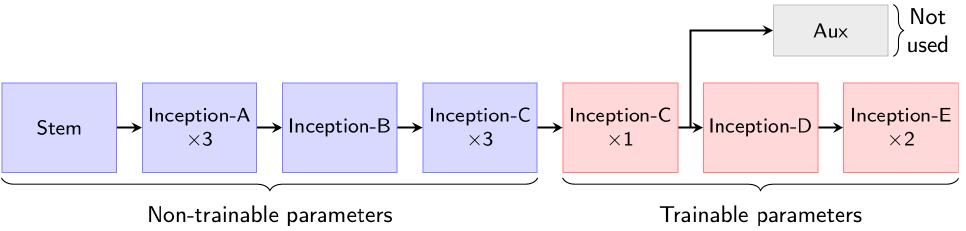
Figure 5. Inception-v3 architecture based on inception modules. The red modules were updated during the training phase while the blue modules were kept